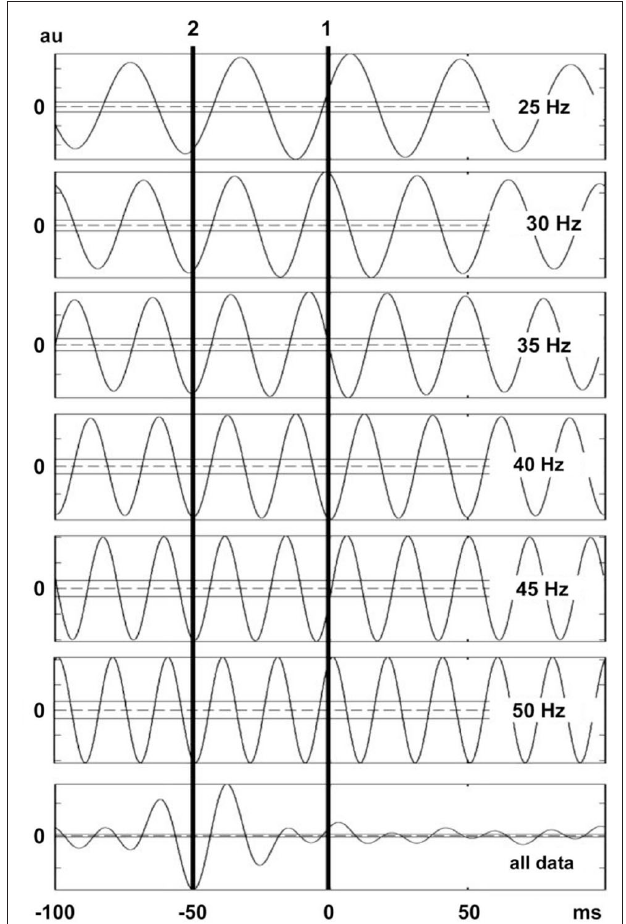
FIGURE 7 | Lag time between vibration stimuli and EMG response. This figure shows the lag time calculated by using cumulant density analysis for six vibration frequency. The second vertical line corresponds to the lag between the local minima of the force trace and the peaks in the rectified MUAP. Note that the lag time between local minima in force trace and the related MUAP peaks are lined up even though the WBV frequencies were different. The confidence limits are marked with horizontal lines in the